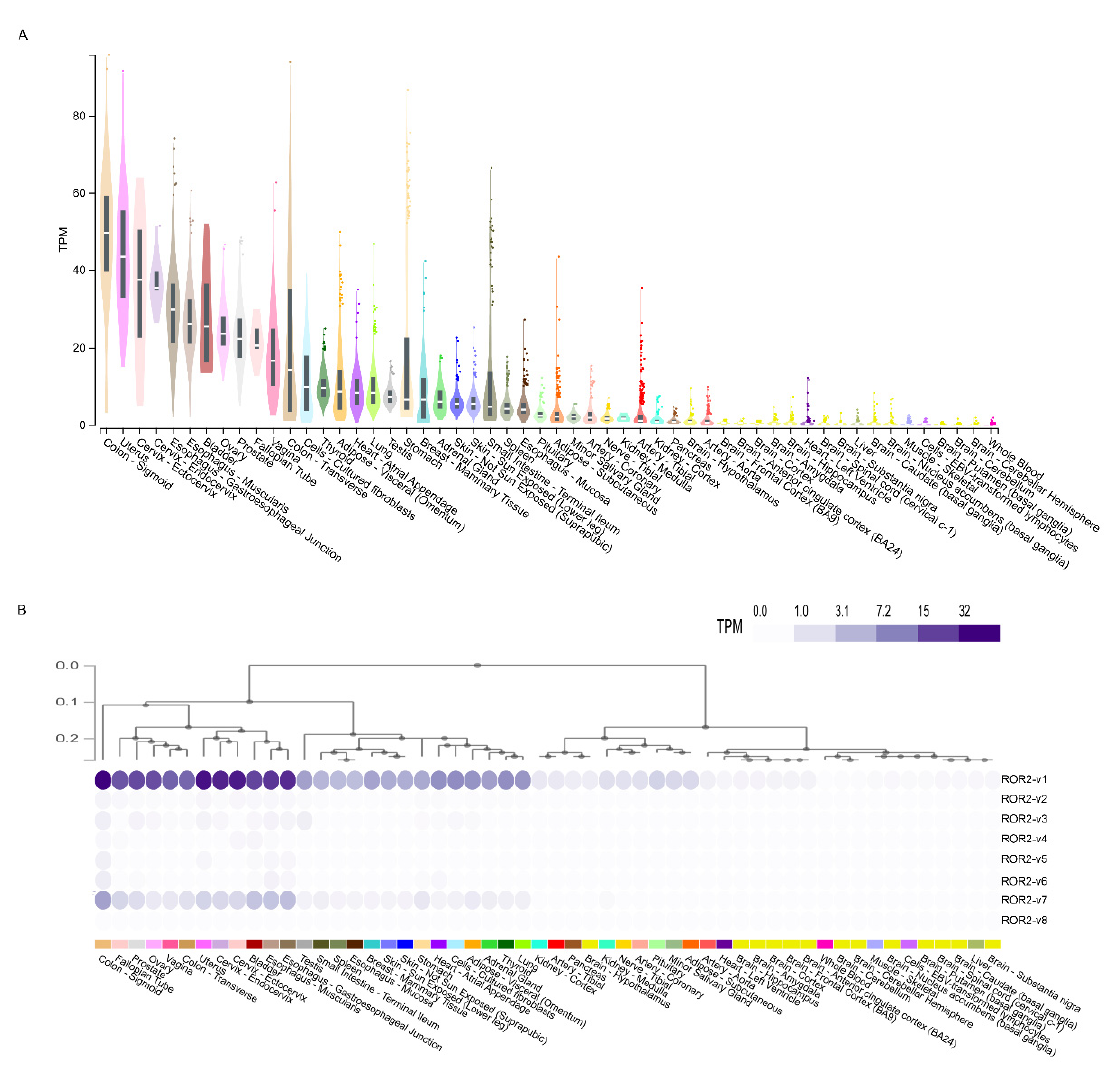
Figure 3. Analysis of ROR2 gene and transcript variant expression in the human body: Gene expression ( A ) and transcript variant expression ( B ) of ROR2 in 17,382 samples across 54 non-diseased human tissues from nearly 1000 individuals profiled by the GTEx project.